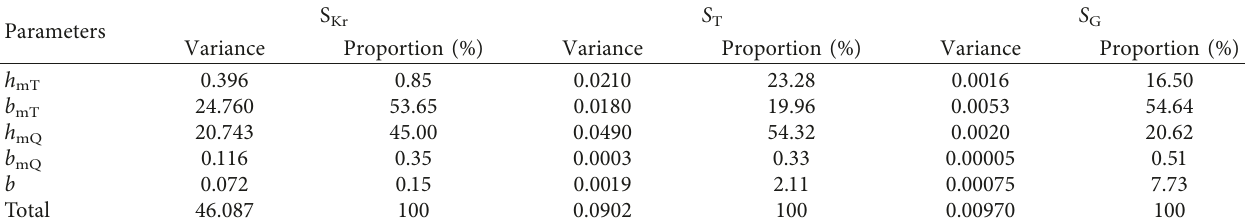
Figure 6: Impact of various factors on G . Table 5: Variance and proportion of the performance indices of each parameter under 4 level factors.